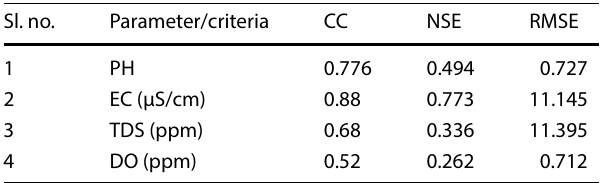
Table 5 ANN model performance for the next location data predic- tion Sl. no.